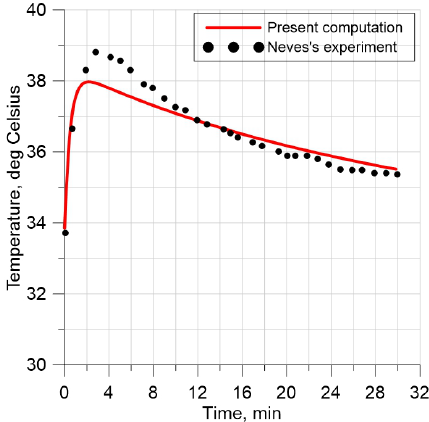
Figure 6. Simulation of the temperature and comparison with measurements